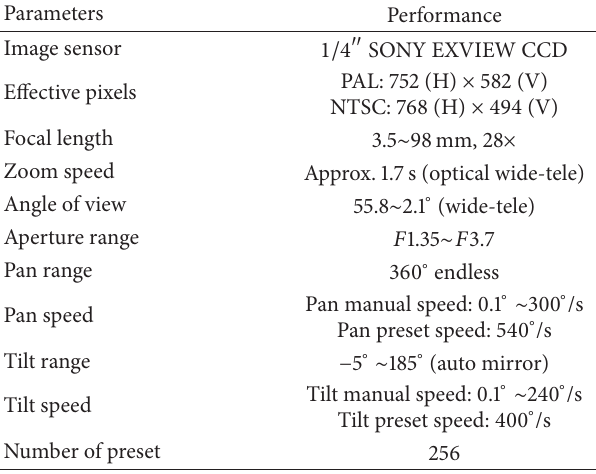
Table 2: The parameters of PTZ